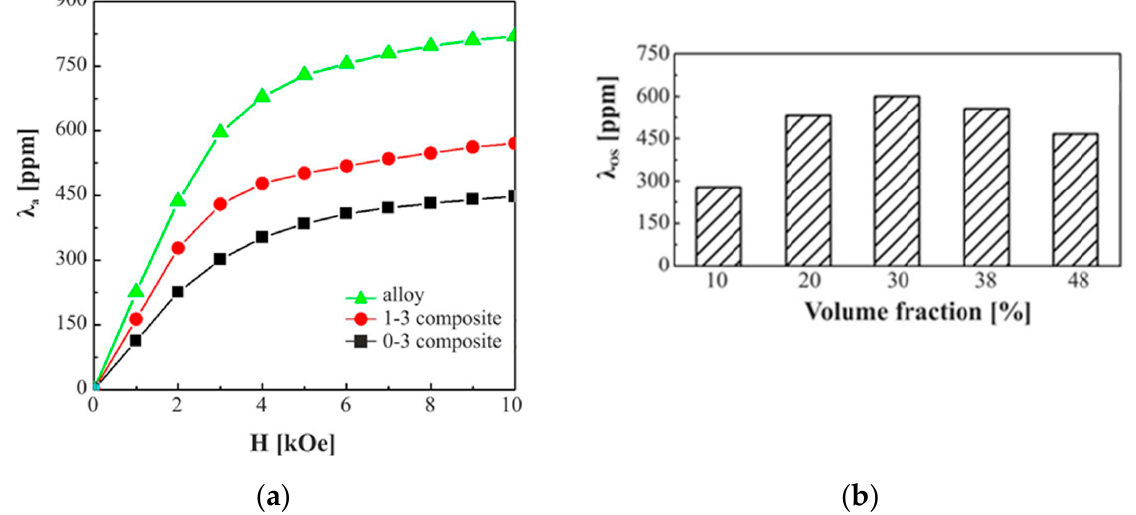
Figure 19. ( a ) Effect of orientation magnetic field on magnetostrictive composites during curing. ( b ) Effect of particle volume fraction on magnetostrictive composites during curing.